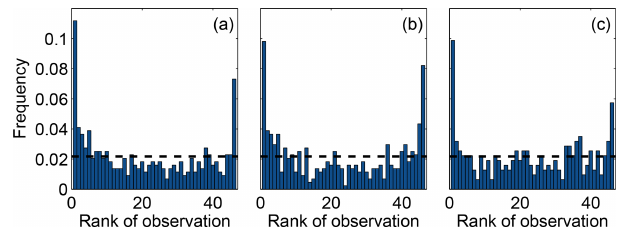
Figure 6. Rank histogram of the 45-member ensemble for wind speed (a) , wind direction (b) and PBLH (c) using 14 rawinsonde sites available over the region. The horizontal dashed line (r) cor- responds to the ideal value for a flat rank histogram with respect to the number of members.